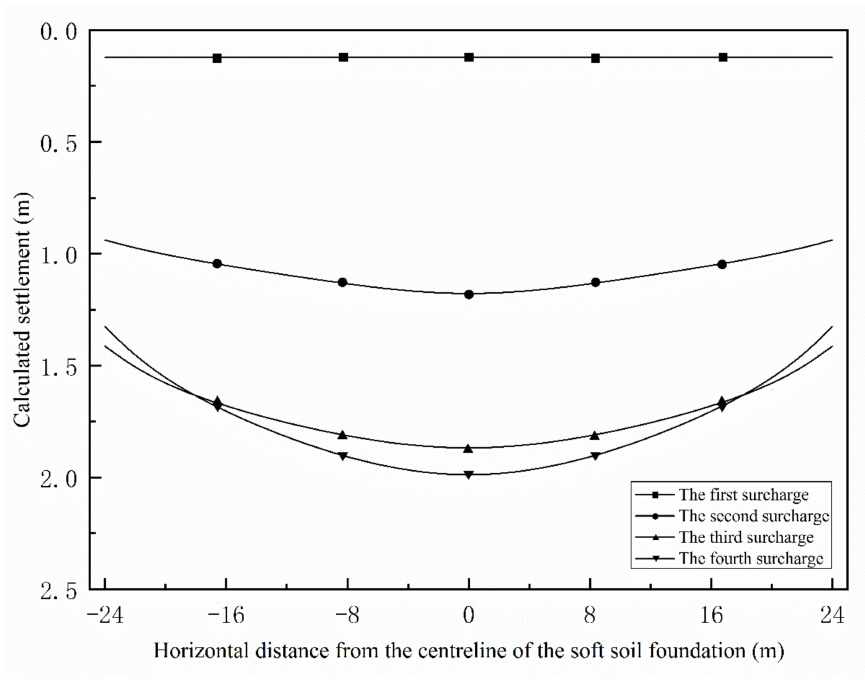
Figure 10. Model calculation results under the four loads.